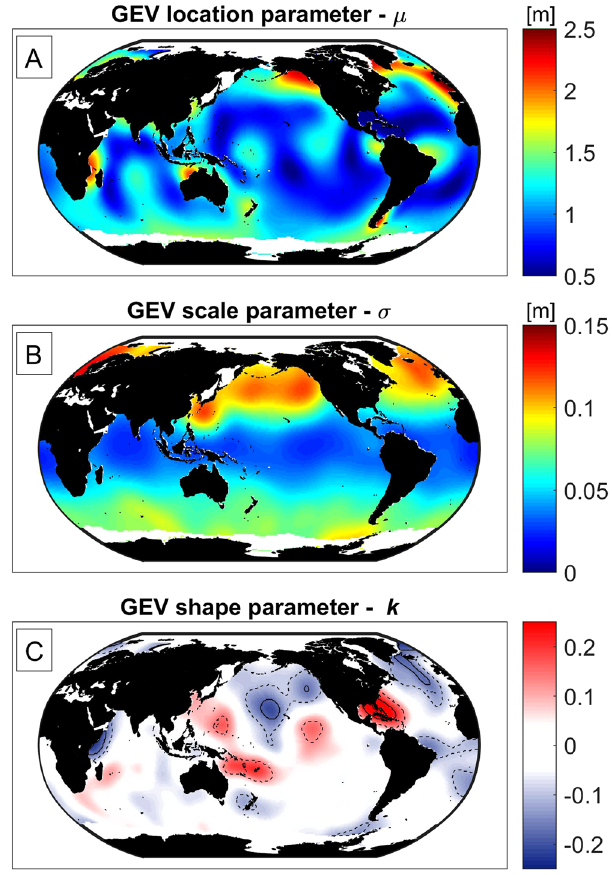
Figure 3. Global estimates of the location ( μ ), scale ( σ ), and shape ( k ) parameters of the GEV distribution of extreme water-level (the sum of wave setup, tide, and storm surge) shown in panels A, B, and C, respectively. The dashed and solid lines in panel C represent contours of k that are significantly different from zero at the 75% and 95% confidence levels, respectively. The maps in this figure were made using Matlab 2016a (https://www.